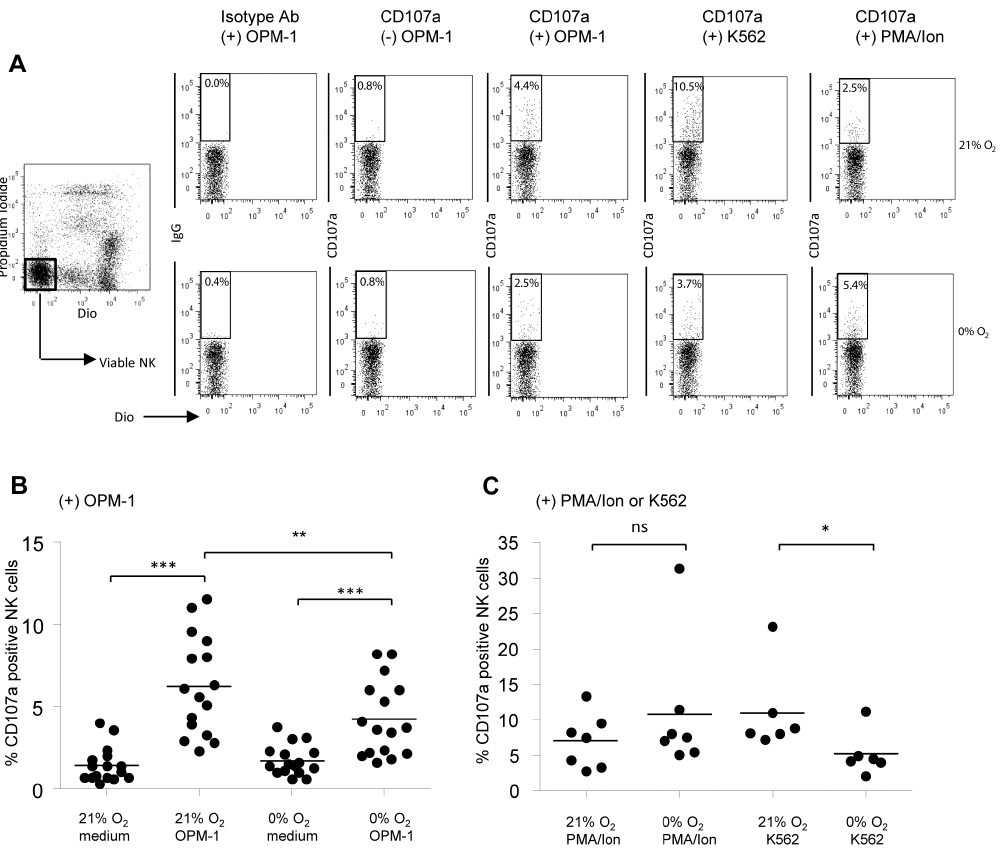
Figure 5. NK cell degranulation can occur under hypoxia but the percentage of degranulating NK cells is decreased. NK cells and target cells (OPM-1 or K562) were pre-incubated for 14–16 hours at 21% or 0% of oxygen before they were combined in a 4.5 hour degranulation assay in the presence of an antibody specific for the degranulation marker CD107a or the corresponding isotype control. Percentage of CD107a positive NK cells for the isotype controls was always less than 0.5%. To some of the cultures PMA/ionomycin was added during the 4.5 hour degranulation assay. The percentage of degranulated, CD107a positive NK cells was subsequently measured by flowcytometry. A) Dot plots depicting data obtained for one representative donor. B) Quantification of dot plots showing the percentage of CD107a positive NK cells upon incubation with medium or OPM-1 target cells. C) Quantification of dot plots showing the percentage of CD107a positive NK cells upon incubation with PMA/ ionomycin or K562 target cells. Each dot in B and C represents mean of duplicates of individual donors. Statistics were performed with one-way repeated measures ANOVA with Bonferroni correction * p , 0.05,** p , 0.01, *** p , 0.001.